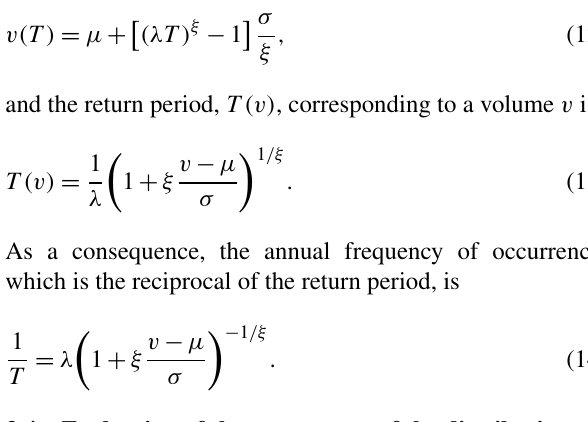
Figure 3. Map of the two test site locations in the north-western Italian Alps. The Buisson site is shown with a red bullet in (a) , the Becco dell’Aquila site is shown with a red bullet in (b)